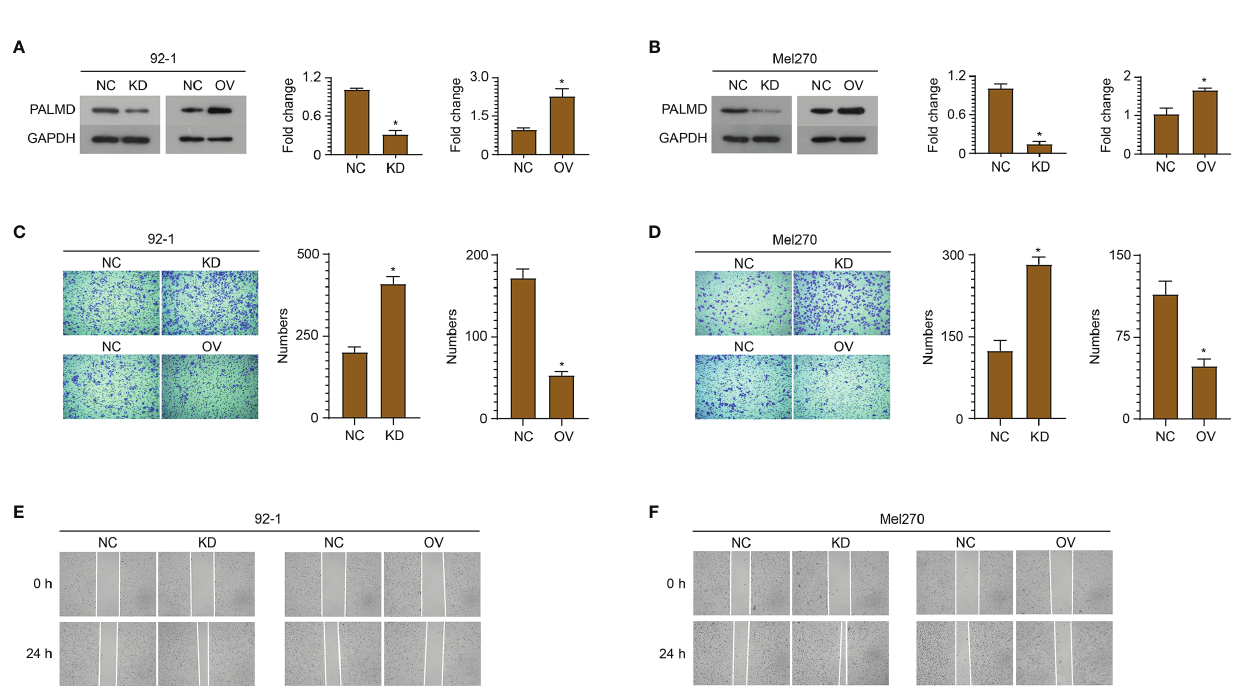
FIGURE 3 | Low level of PALMD is bene fi cial to the motility and metastasis of UM cells. siRNA speci fi cally targeting PALMD or pcDNA3.1 overexpression plasmid was transfected into 92-1 (A) and Mel270 (B) cells to down- (KD) or up- (OV) regulate the expression of PALMD. After transfection, the invasion of 92-1 (C) and Mel270 (D) cells was measured using Transwell assay, the migration of 92-1 (E) and Mel270 (F) cells was detected using scratch assay. *P <